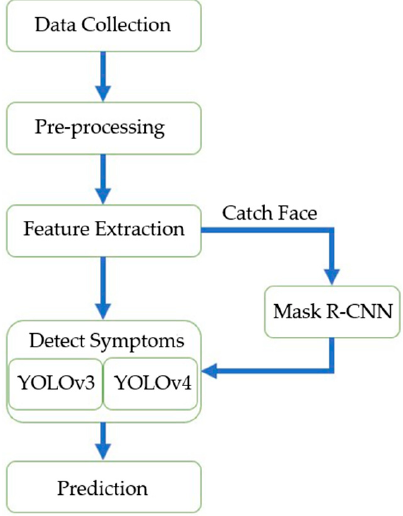
Figure 3. The overall schematic of the proposed model.